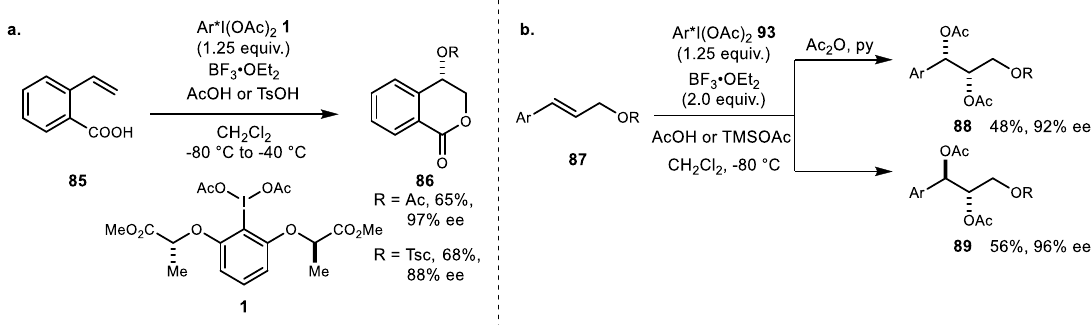
Molecules 2019 , 24 , 2634 10 of 23 Scheme 16. ( a ) Oxazoline and thiazoline synthesis; ( b ) Ritter-type amidation; and ( c ) sulfeno- and selenofunctionalization. 4. Alkene Diacetoxylation In terms of the dioxygenation reactions of alkene, recent advances have been mainly in regard to the reaction mechanism and synthetic applications with natural products, as reported by Fujita and coworkers in 2010. Initial screening of chiral lactate-based hypervalent iodine reagent 1 was reported in 2010 [68], and it resulted in both high enantioselectivities and endo-selective